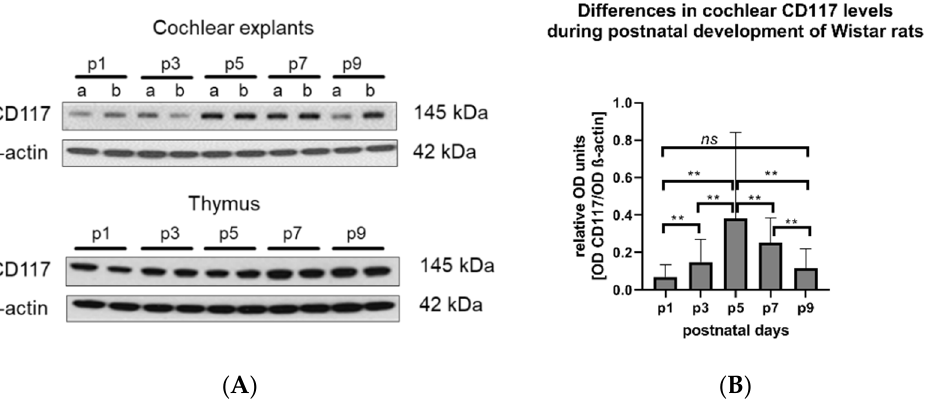
Figure 4. The levels of CD117 in the cochlea of Wistar rats vary during postnatal development. ( A ) Representative Western blot (WB) images showing CD117 (MW 142 kDa) expression in cochlear explants ( A upper panel) and the thymus ( A lower panel) isolated from naïve Wistar rats (p1–p9). β -actin (MW 42 kDa) was used as loading control; 6 µ g proteins per lane were loaded. In the cochlear panel: a—apical, b—basal turn of the cochlea. In the thymus panel, each line corresponds to a di ff erent tissue sample. ( B ) Optical density (OD) of each sample ( n = 16 cochleae for each developmental time point) was measured and expressed as the OD of CD117 divided by the OD of ß-actin from the same sample. The statistical analysis indicated significant di ff erences between the CD117 expression on the consecutive developmental days (one-way ANOVA, F (4,75) = 4.819, ** p = 0.0016). ns : No statistical di ff erence was detected between the OD of CD117 on p1 and p9 (Mann–Whitney